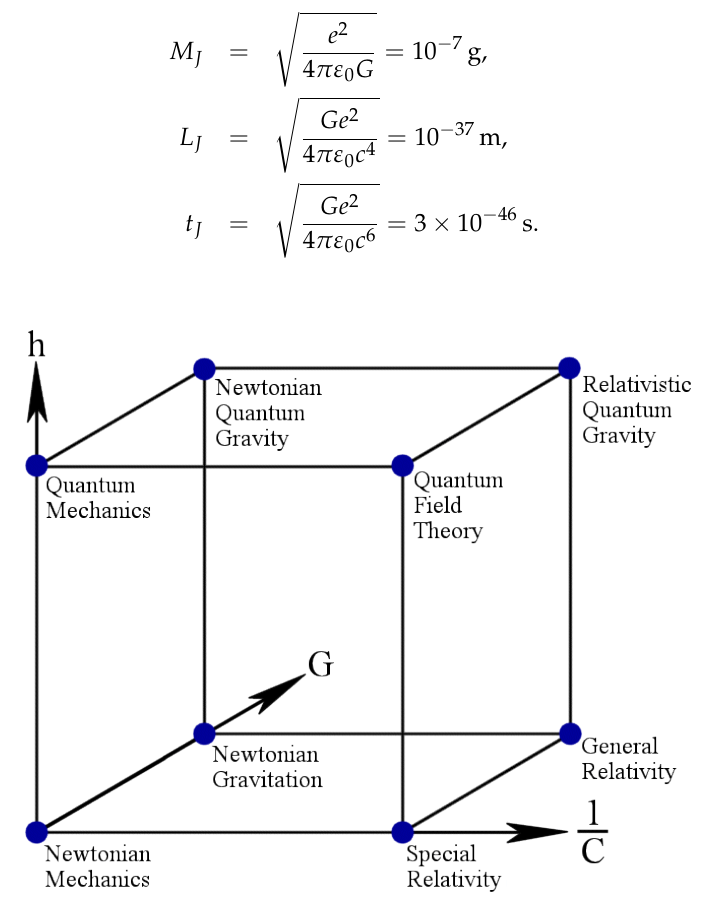
Figure 1. Bronshtein-Zelmanov-Okun cube, or the cube of the physical theories [11]. Three orthonormal axes are marked by 1/ c , h and G . The vertex ( 0,0,0 ) corresponds to non-relativistic mechanics; ( c ,0,,0) to special relativity; (0, h ,0) to non relativistic quantum mechanics; ( c ,, h ,0) to quantum field